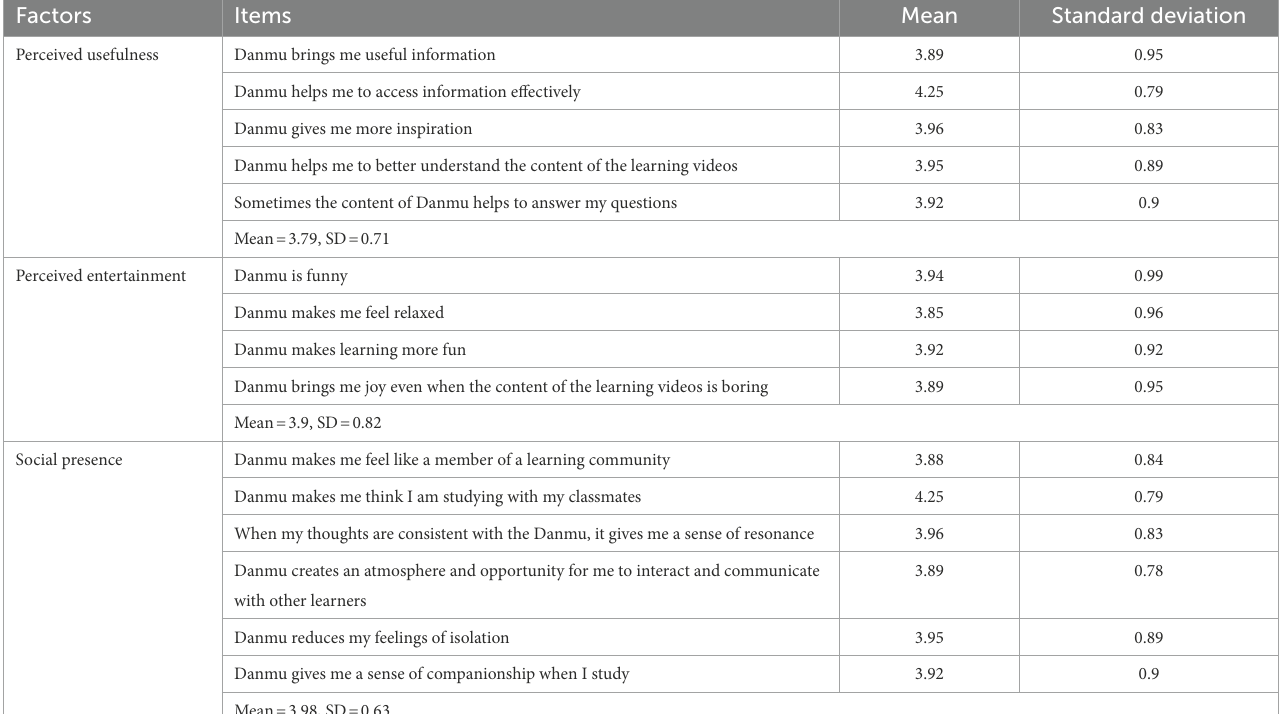
TABLE 2 Factors of gratifications of learning using Danmu videos.